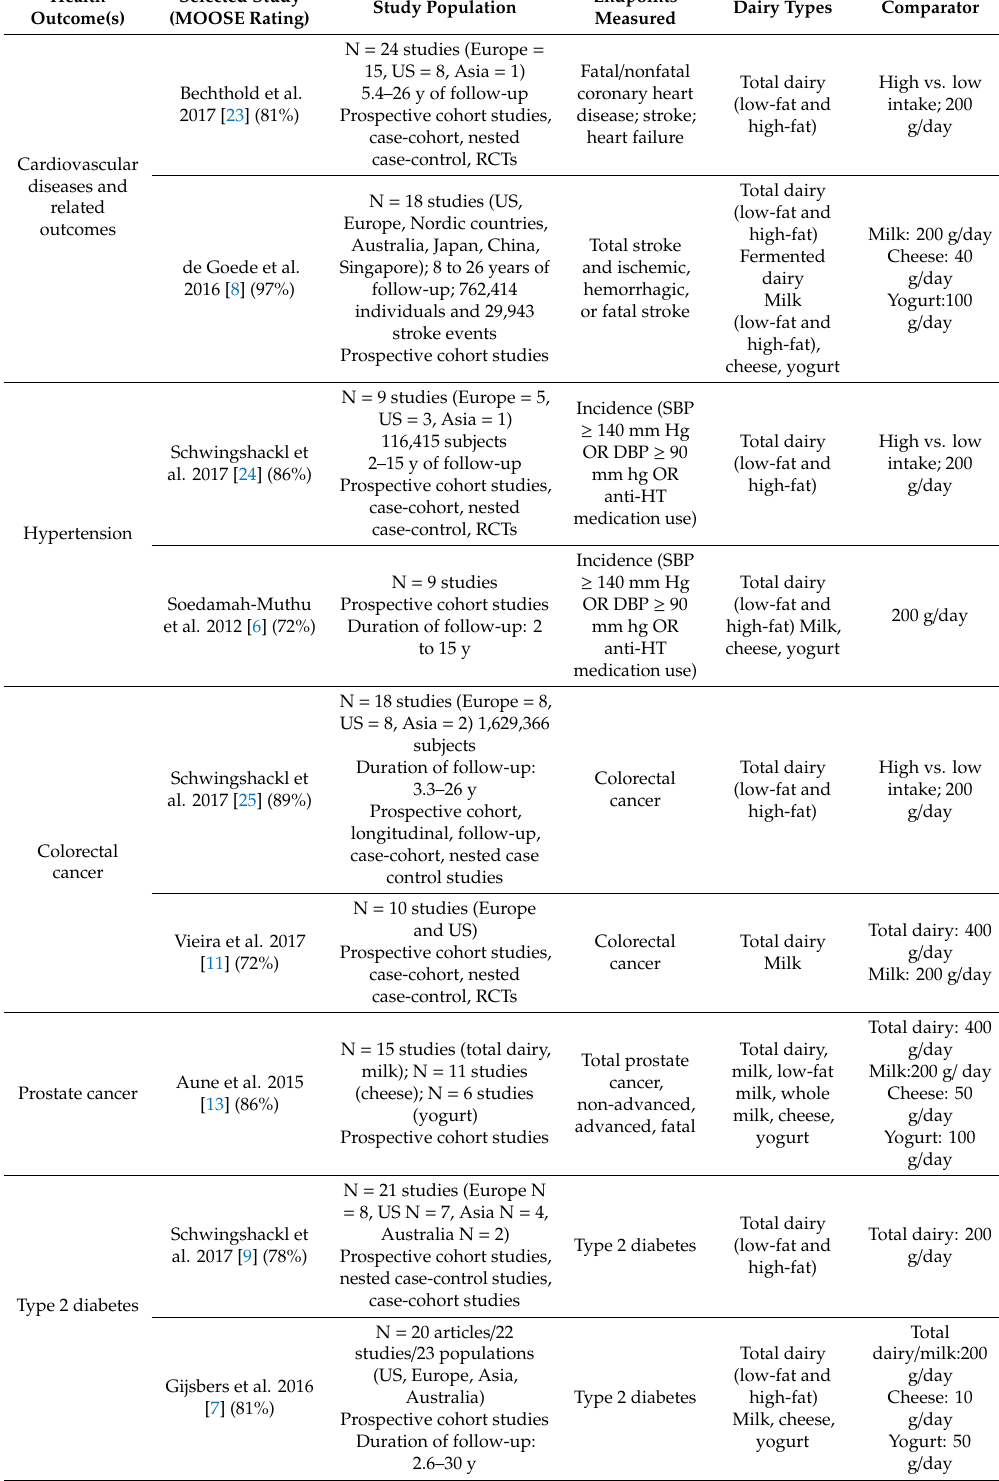
Table 1. Summary of selected studies measuring the association between dairy consumption and health